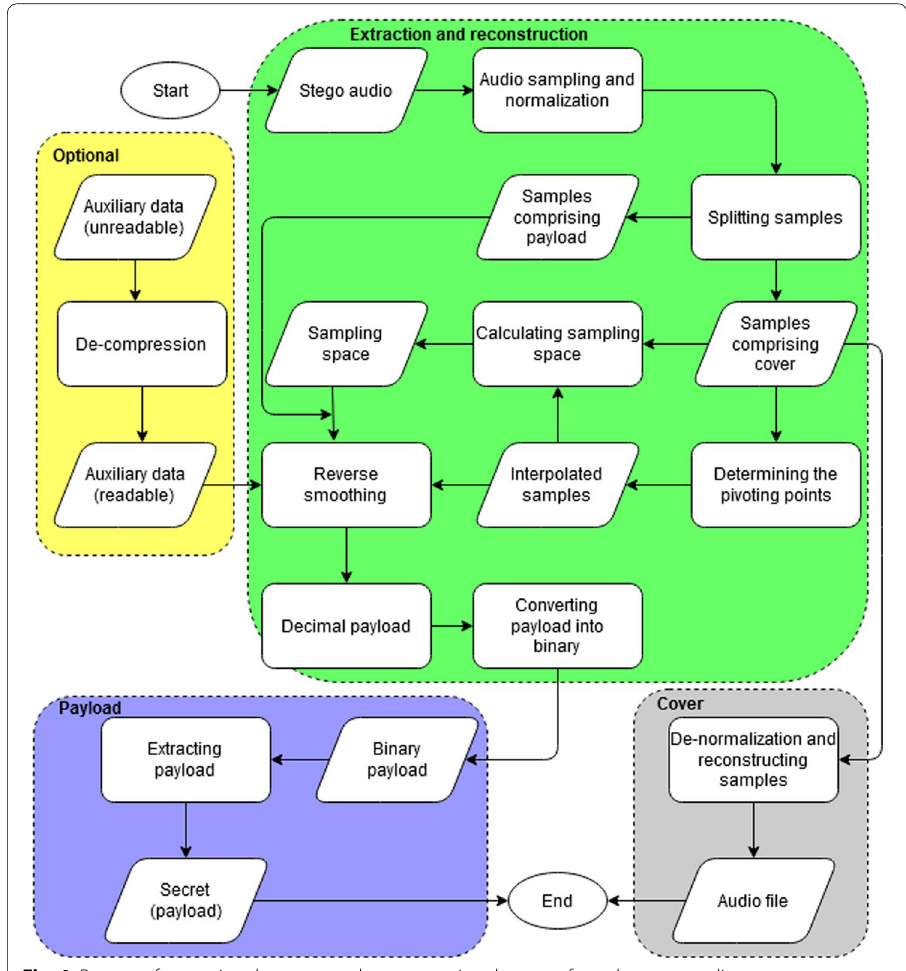
Fig. 4 Process of extracting the secret and reconstructing the cover from the stego